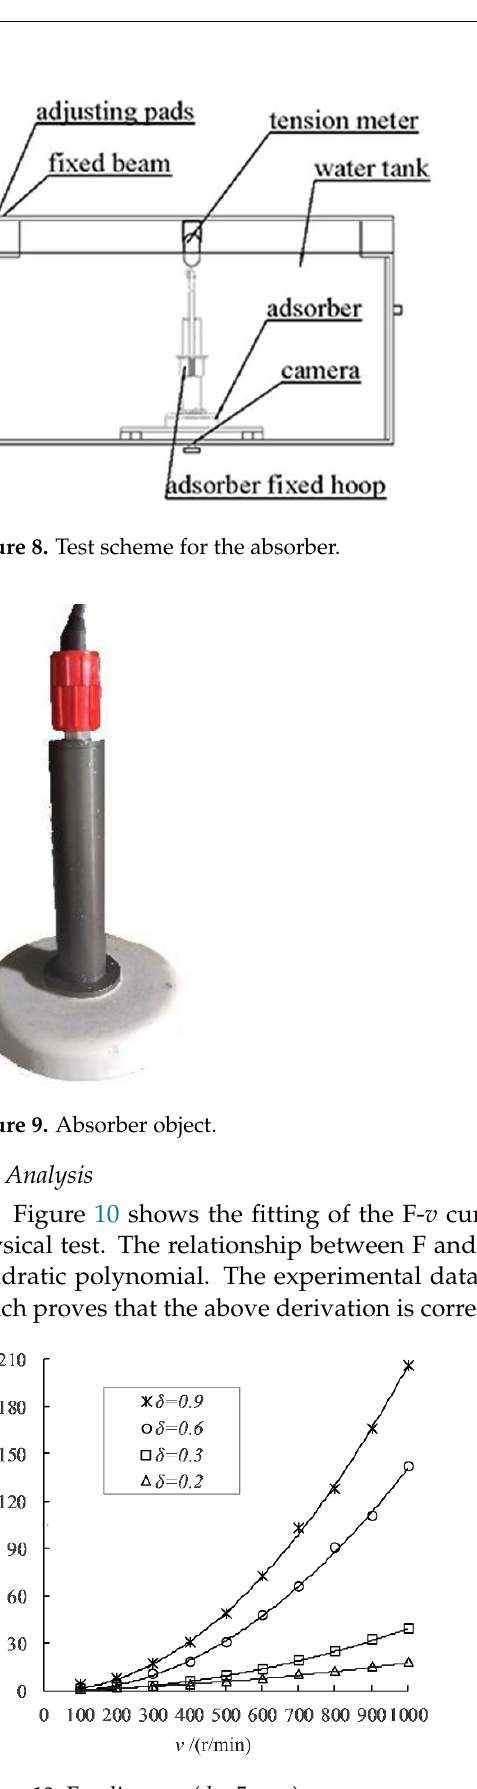
Figure 10. F- v diagram ( d = 5 mm).